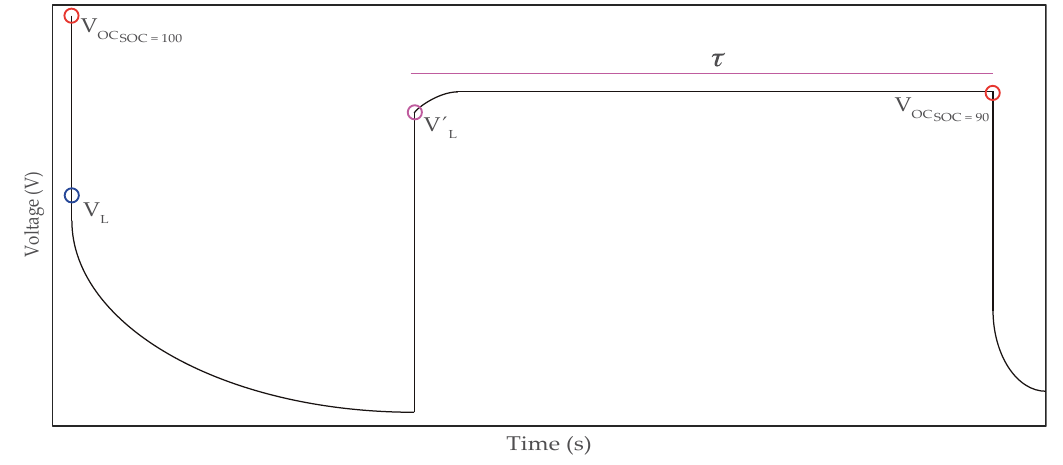
Figure 4. Experimental current discharge in a